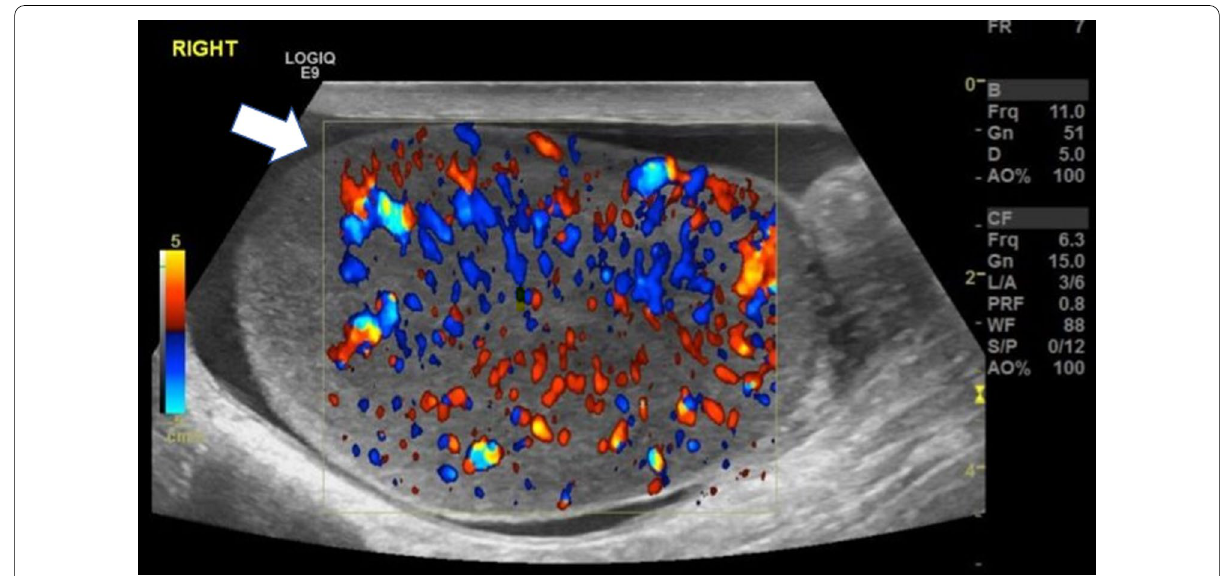
Fig. 1 USS right testicle showing diffuse enlargement with hypervascularity